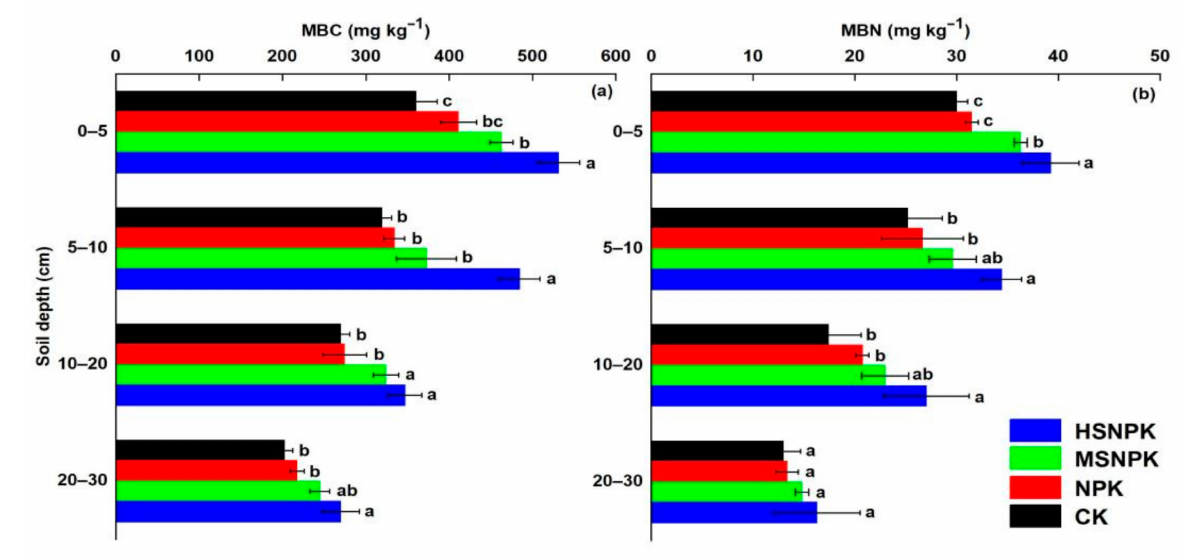
Figure 4. Changes in ( a ) soil MBC and ( b ) MBN content at different soil layers under different treatments. The values are means ± SD ( n = 3). Different letters mean statistically significant differences at the 0.05 level. CK: unfertilized control; NPK: mineral NPK fertilizer; MSNPK: moderate wheat straw incorporation (3 t ha − 1 ) plus NPK; HSNPK: high wheat